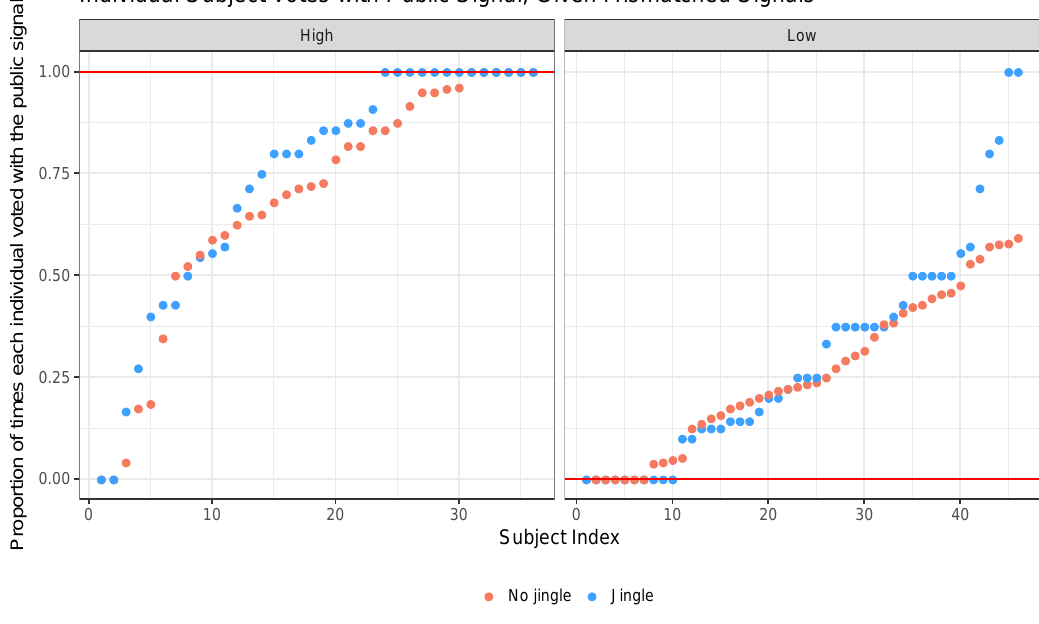
Figure A8. Jingle effect (individual sessions). Proportion of times each individual voted according to the publice signal. The left image plots values for sessions where Q > q , the right one Q < q . Blue dots correspond to the public signal displayed with the